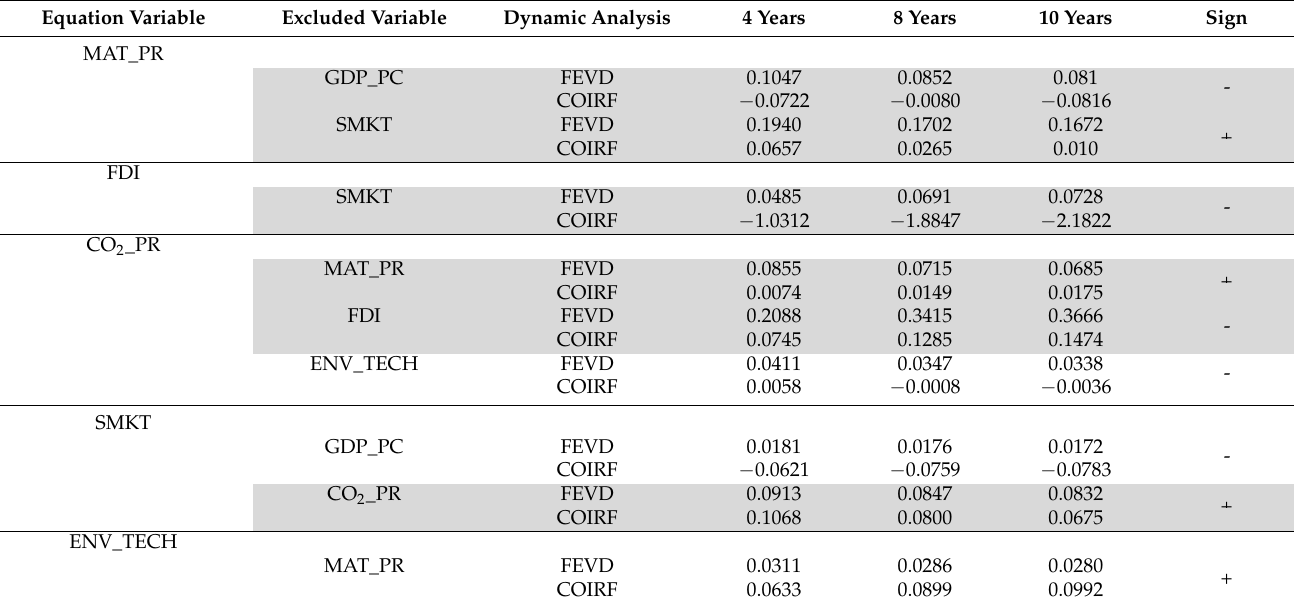
Table 5. Analysis of causality and amplitude relationships in the EU-15